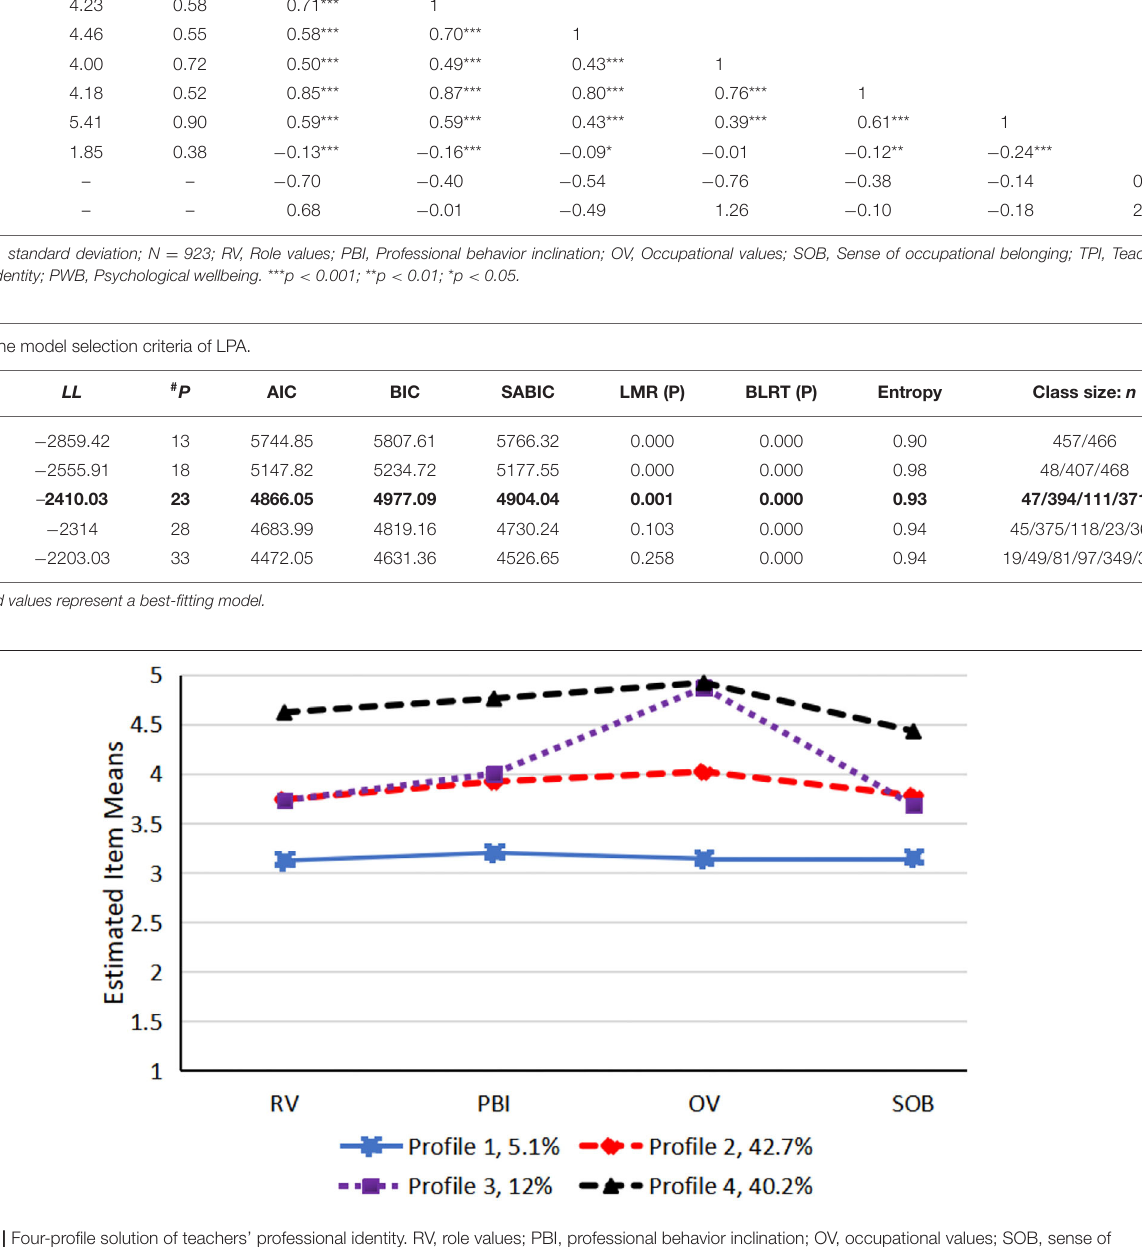
there was no significance between the MPI profile and the HOV